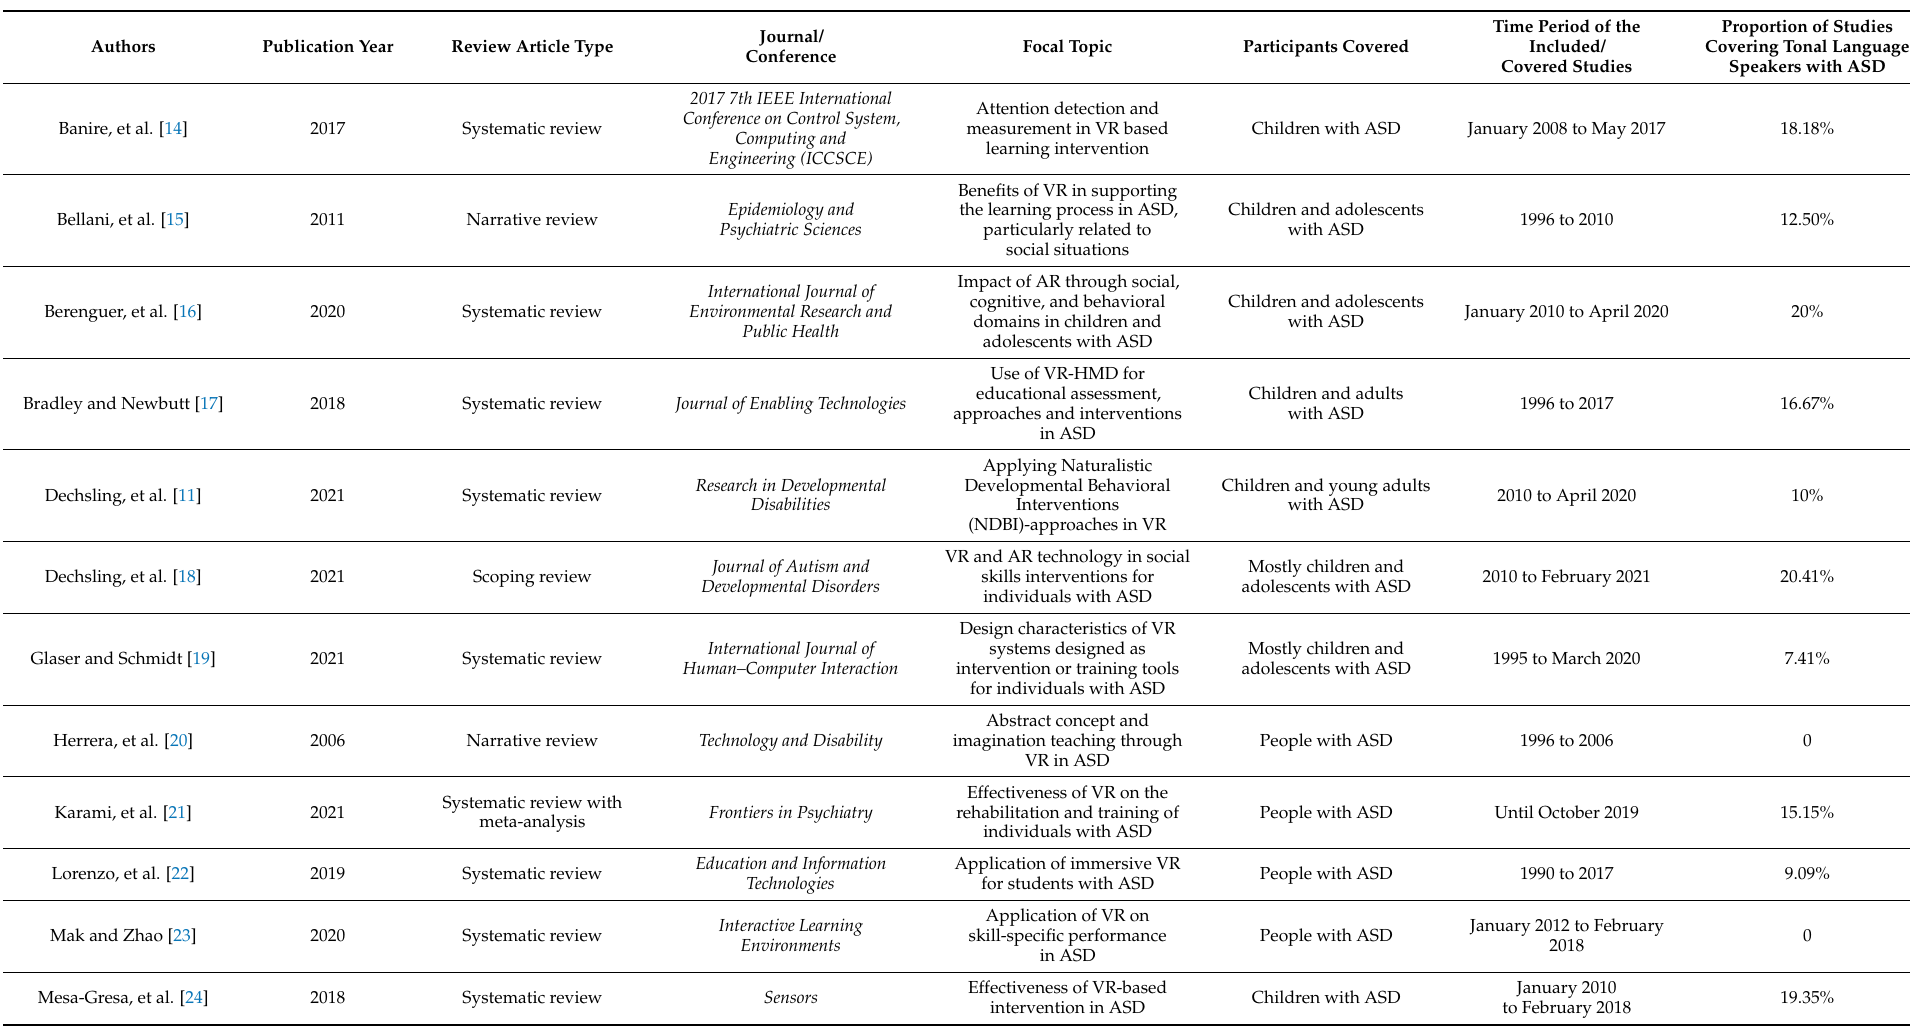
Table 1. A summary of existing reviews on the use of VR for ASD